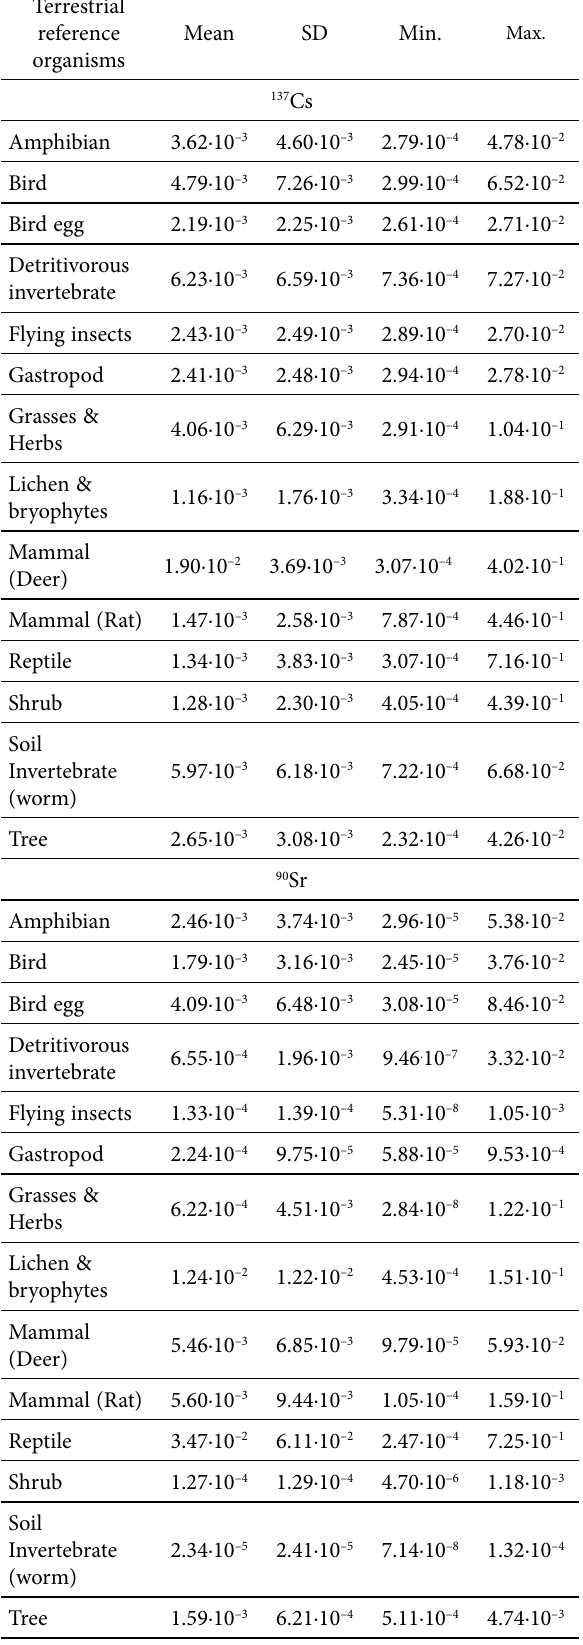
Table 2. Estimated total dose rates (µGy h –1 ) to terrestrial reference organisms attributed to artificial radionuclides